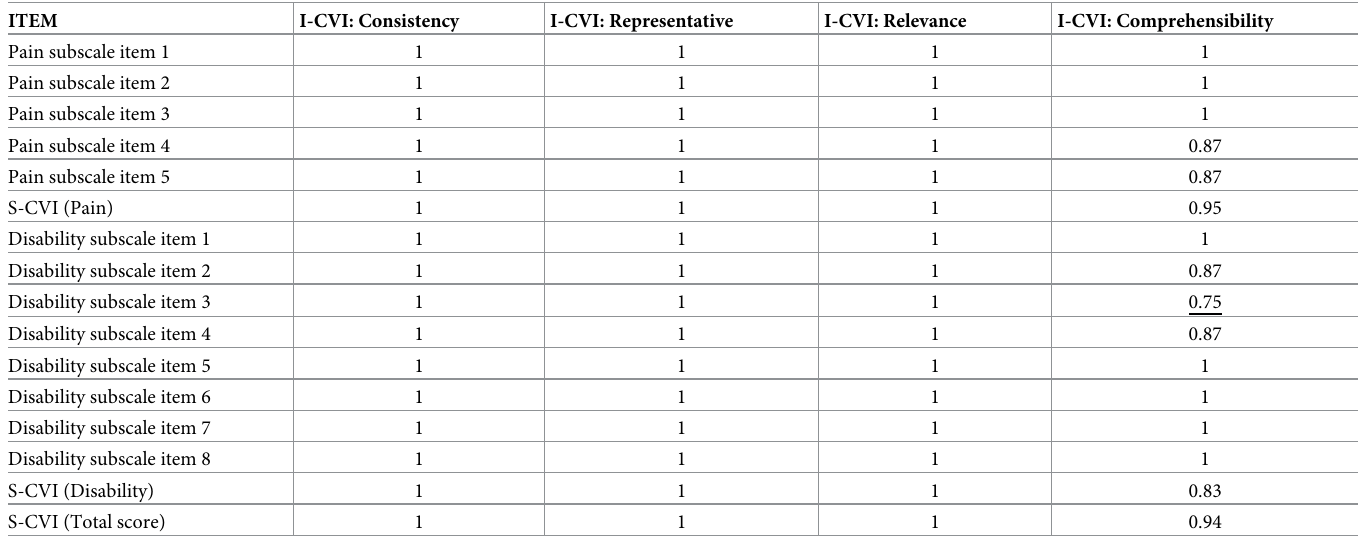
Table 2. Content validity of